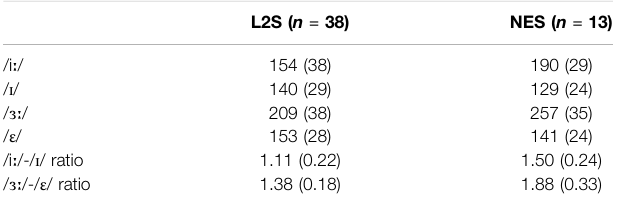
TABLE 4 | Mean vowel duration (in ms) and duration ratio for L2 speakers (L2S) and English native speakers (NES). L2S ( n =